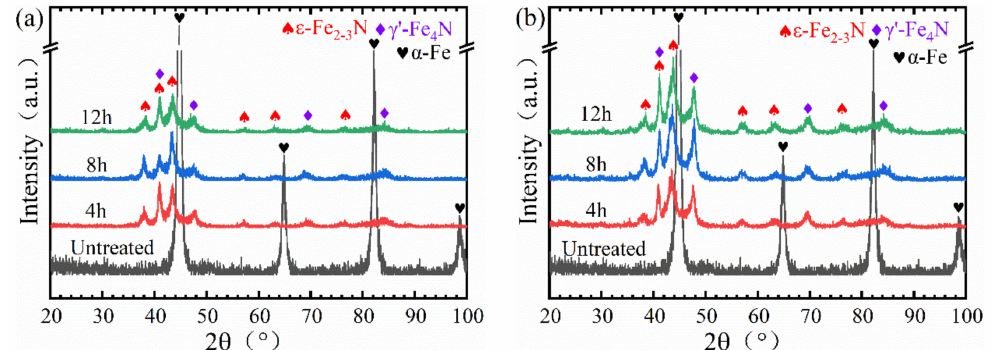
Figure 5. XRD pattern of the modified layer of 3Cr13 steel after plasma nitriding at different times ( a ) Without RE ( b ) With